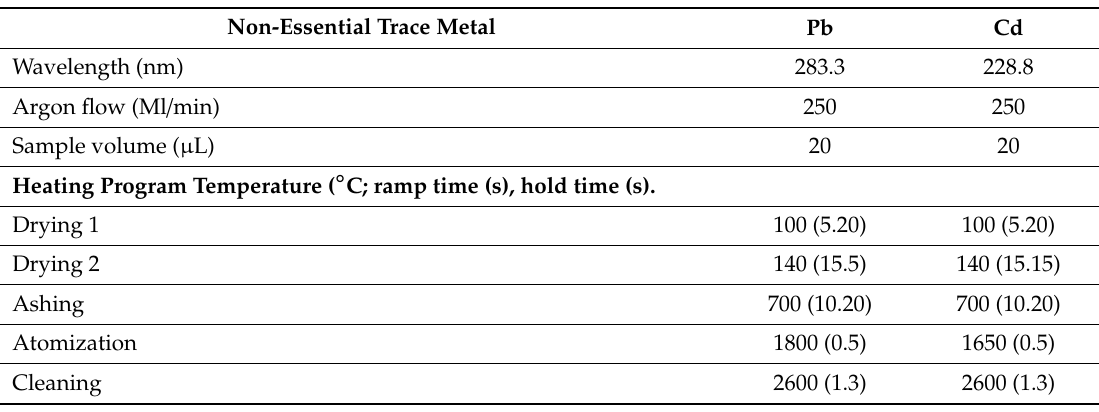
Table 4. GFAAS program for non-essential trace elements Pb and Cd.